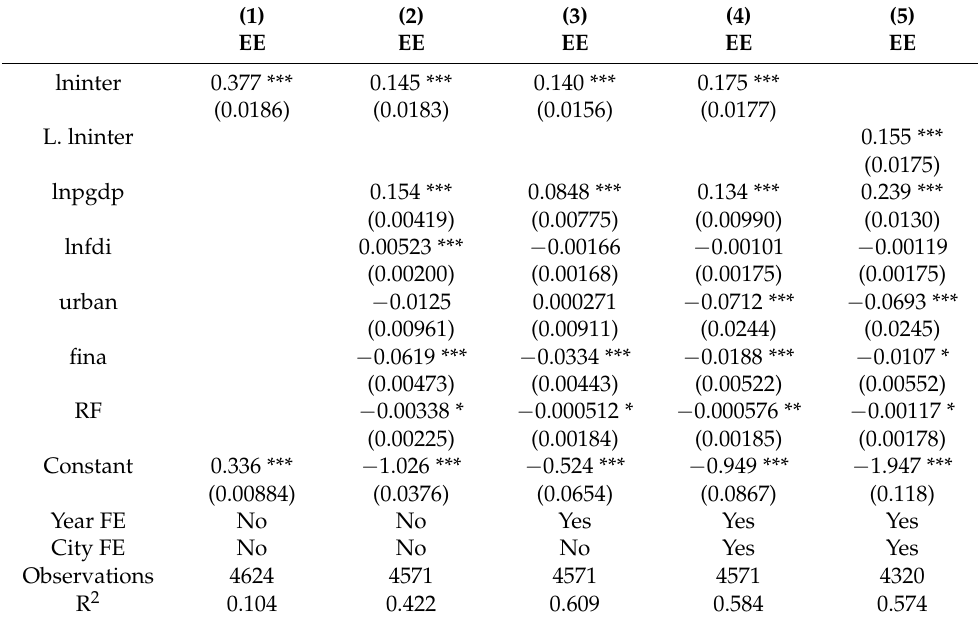
Table 2. Impact of imports of intermediate goods on energy